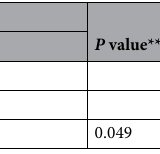
Table 3. An evaluation of the identified variation in molecular results and pathology investigations. *In total of 13 patients, one patient was undiagnosed with TGS. ** P associated with Fisher’s exact